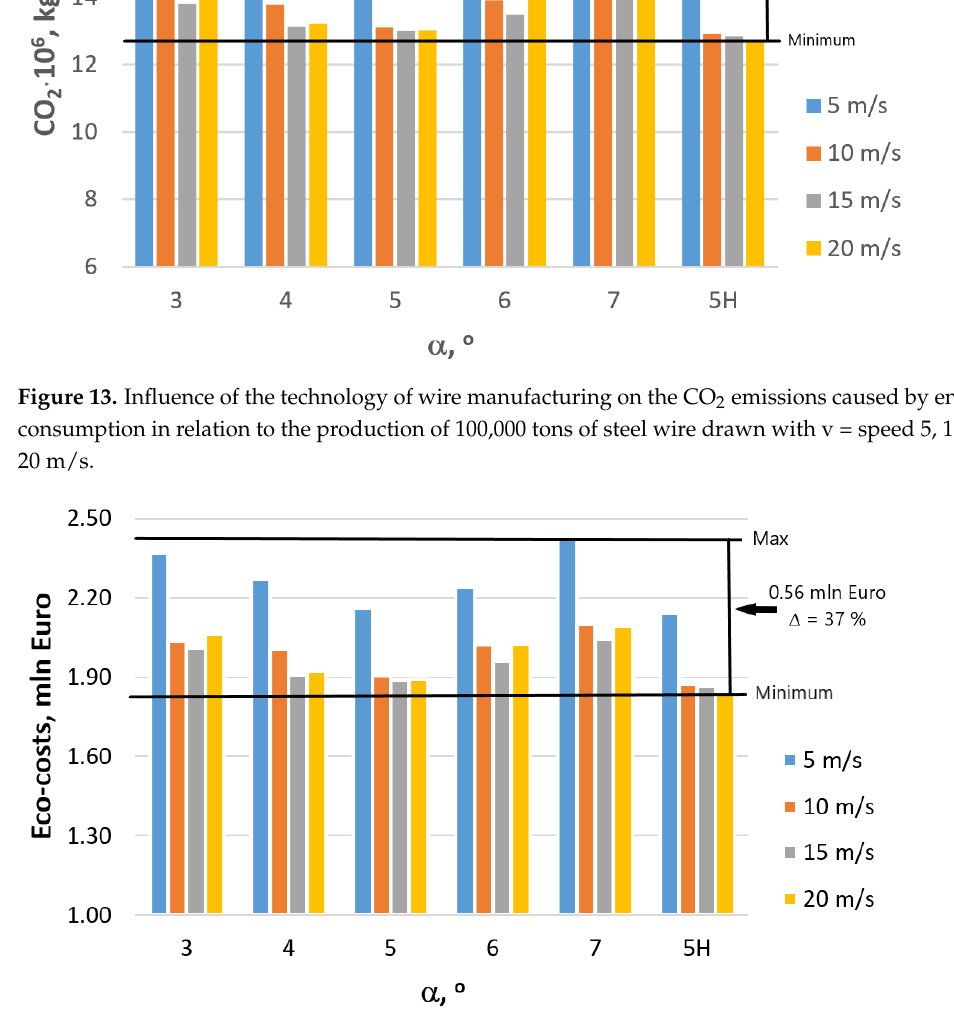
Figure 14. Influence of the technology of wire manufacturing on the CO 2 emissions caused by energy consumption in relation to the production of 100,000 tons of steel wire drawn with speed v = 5, 10, 15, 20 m/s. Table 4. Eco-costs related to the consumption of electric energy E required to manufacture 100,000 tons of 2.2 mm wire, depending on the drawing technology used, where α —drawing angle, H—hydrodynamic dies, v—drawing